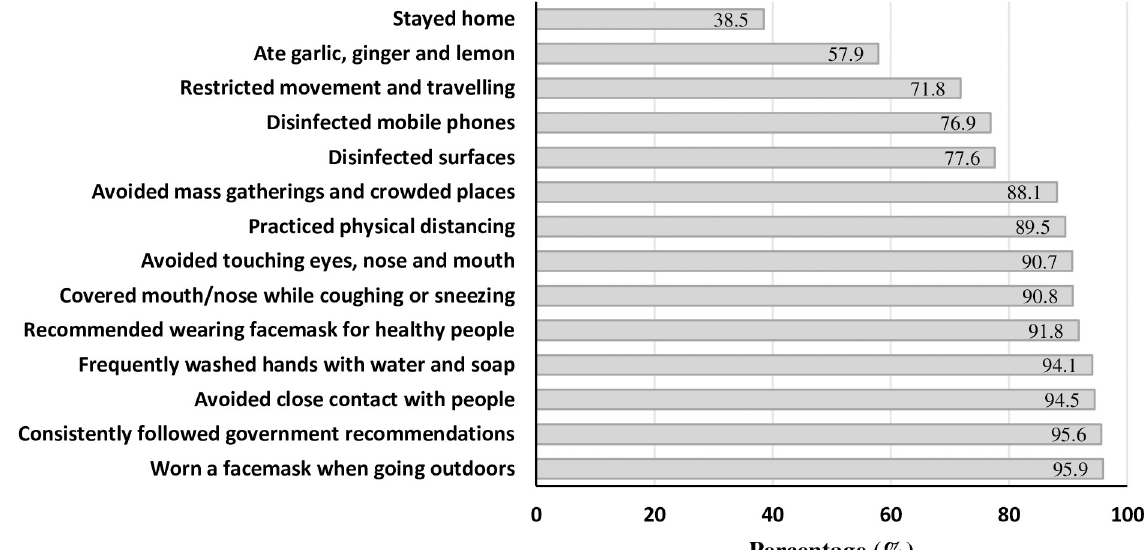
Fig 1. The proportion of respondents who responded to the 14 social and preventive practices in response to COVID-19, Addis Ababa, June 2020. https://doi.org/10.1371/journal.pone.0257112.g001 The responses of the 14 social distancing and preventive practices in response to COVID-19 were added to produce the score of the overall reported practice. Summing the responses across the total measures for each individual revealed a mean sample score of 11 ± 2.3 measures taken and a median of 12 measures with an interquartile range (IQR) of 2, on a scale of 14. About 24% and 20% of the respondents scored 13 and 14 responses on the social and preventive measures, respectively, while 10.6% responded 8 or less types of measures taken in